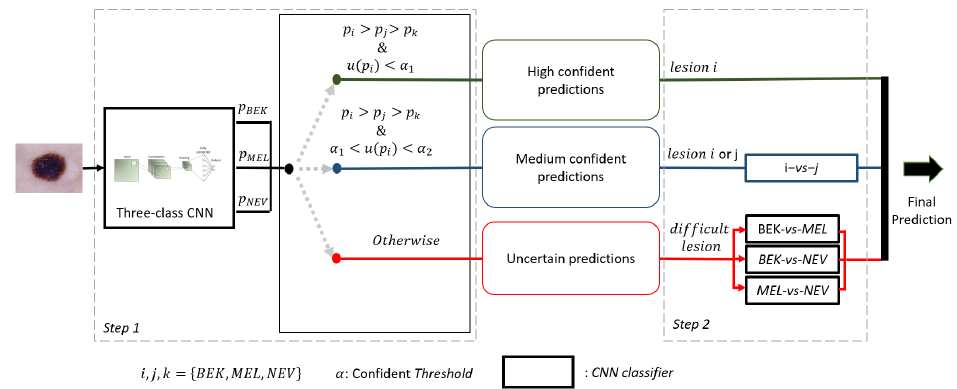
Figure 3. Our novel framework to ternarily classify Melanoma (MEL), Nevi (NEV) and Benign Keratosis (BEK). An image of a skin lesion is spent in a first set consisting of three CNNs trained to classify one lesion versus the two other lesions. The second step, depending on the group in which the image was previously placed based on the confidence score, provides the final decision with the associated